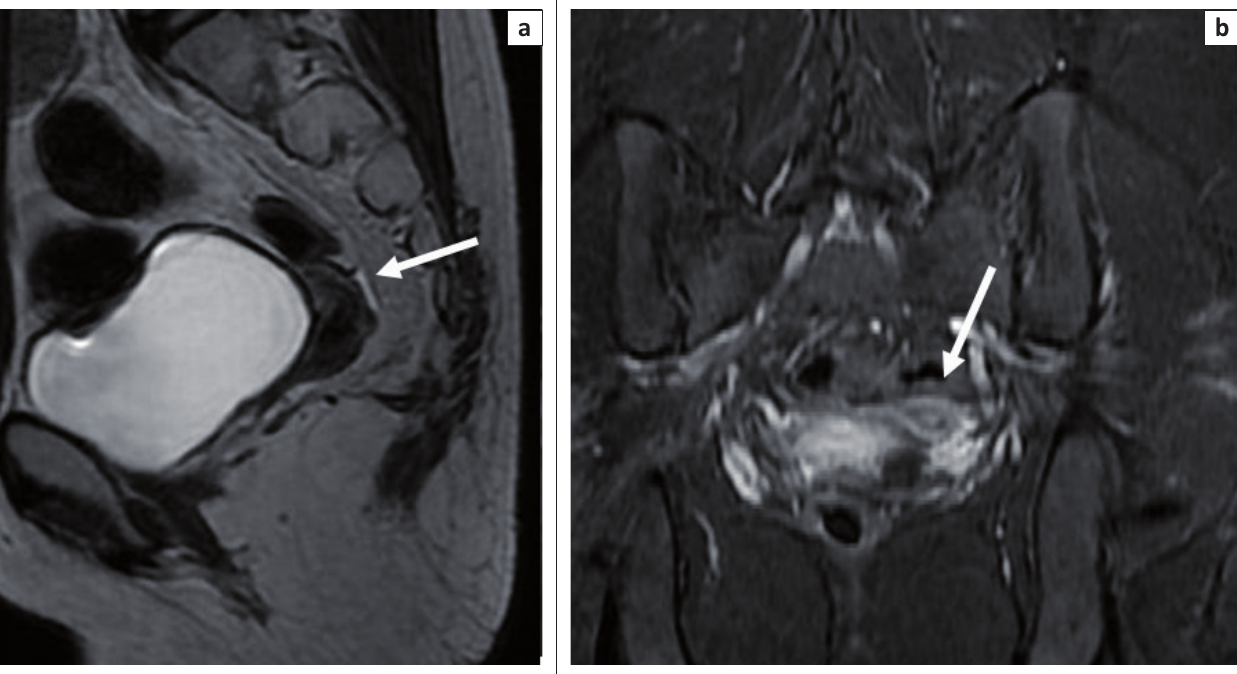
FIGURE 15: Sagittal T2 sequence (a) demonstrating a rudimentary uterus. Short tau inversion recovery (STIR) coronal (b) shows the rudimentary uterus with a cavity and absent